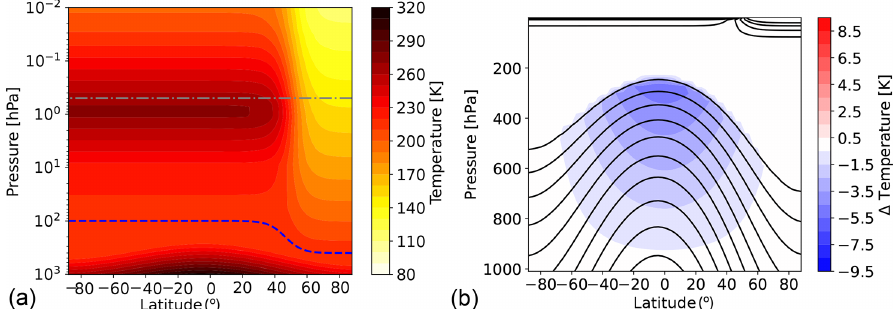
Figure 2. (a) Equilibrium temperature (in K) for p Tw = 400hPa and γ = 2Kkm − 1 together with the transition pressure p T (φ) (dashed blue line) and the pressure above which damping sets in (dashed–dotted gray line). (b) T eq as given by the original PK02 implementation (black contours) and difference in T eq between simulations with reduced δ z = 4 . 3K and with standard δ z = 10K (colors).